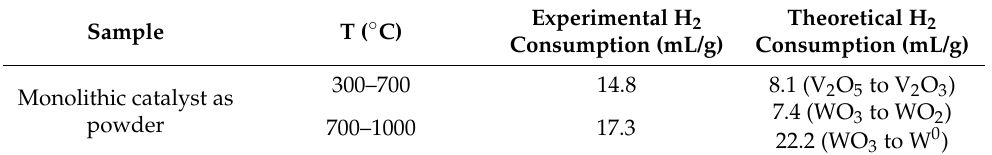
Table 5. Experimental H 2 consumption values derived from TPR, comparison with theoretical data.